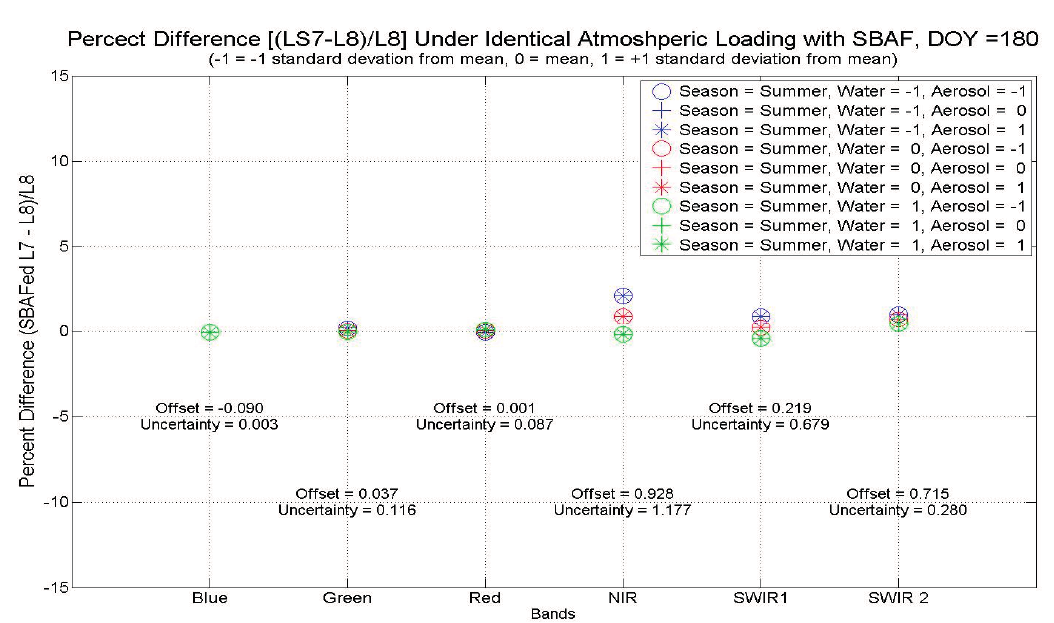
Figure 14. Percent difference between L7 and L8 coincident looks—Summer.